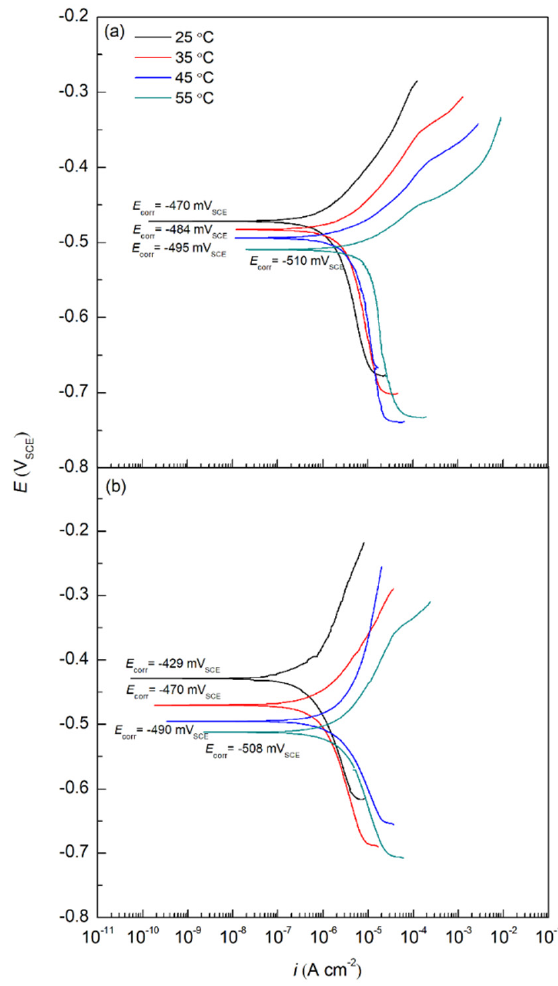
Figure 1. PDP curves for carbon steel rebars in 0.6 M Cl − SCPS in the ( a ) absence, and ( b ) presence of 0.6 M sodium succinate at 25, 35, 45, and 55 °C .